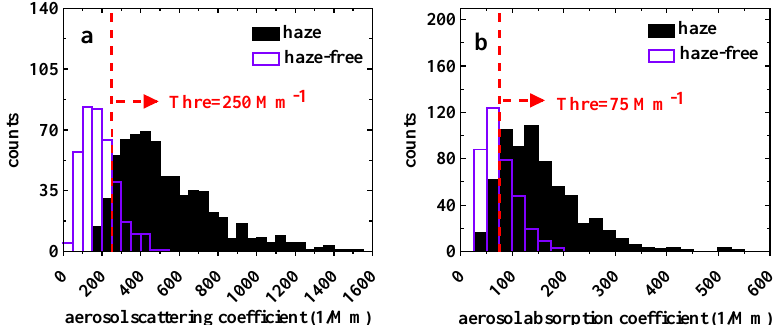
Figure 7. Haze-free (purple histogram) and haze (black column) frequency histograms of aerosol scattering ( σ s ) ( a ) and absorption coefficients ( σ ab ) ( b ). The red dashed line represents the thresholds for distinguishing between haze and non-haze aerosols.